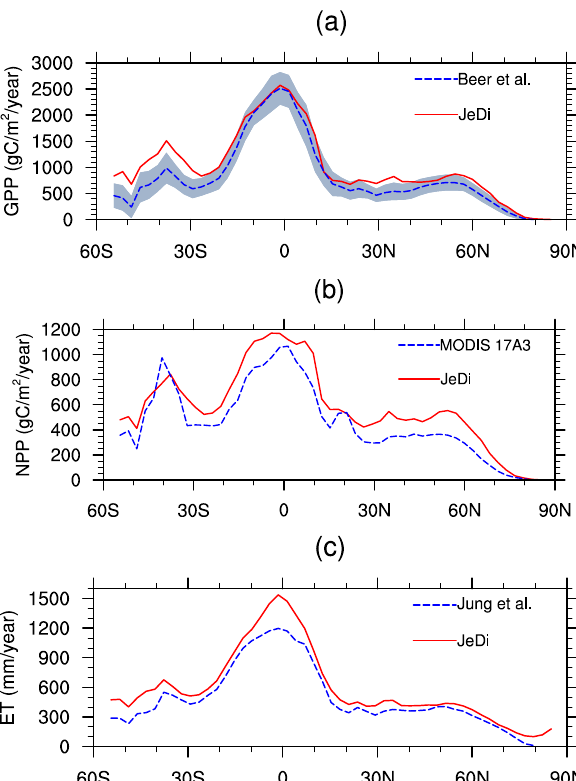
Fig. 3. Comparison of mean annual zonally averaged fluxes as simu- lated by JeDi-DGVM with (a) data-driven model estimates of gross primary productivity (Beer et al., 2010), (b) net primary productiv- ity from the MODIS MOD17A3 Collection 4.5 product (Heinsch et al., 2006; Zhao et al., 2005, 2006), and (c) data-driven model es- timates of evapotranspiration (Jung et al., 2010). The blue-shaded region in (a) represents the median absolute deviation of the five di- agnostic models used in producing the data-driven model estimate.